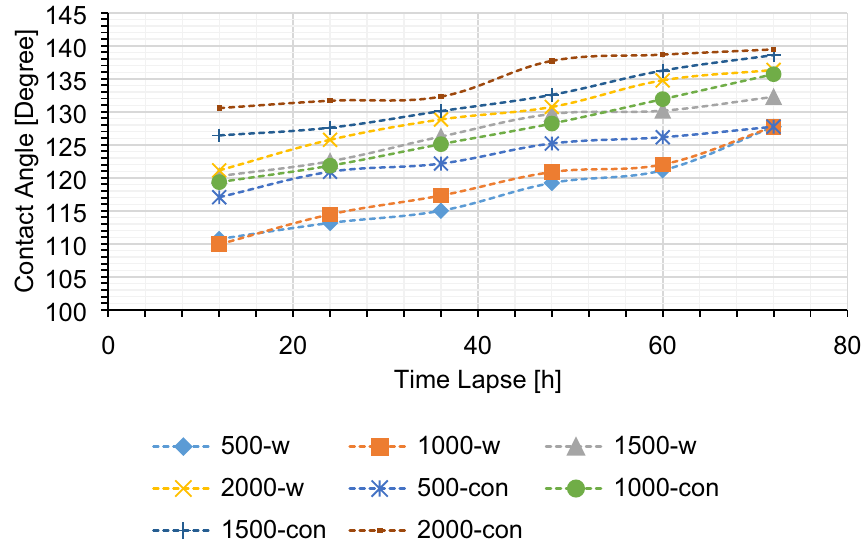
Fig. 9 The obtained curves from the contact angle experiments due to the droplet of water and condensate in the presence of the hydrocarbon gas on the aged carbonate sections of R404A gas at 70 °C and different pres- sures of aging